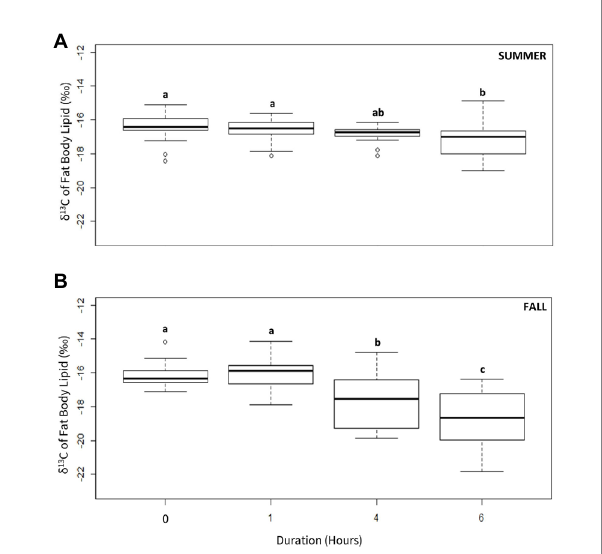
FIGURE 3 δ 13 C values of the fat body from 5-day old true armyworm moths after different periods of force flight when reared under (A) summer or (B) fall conditions. Letters indicate statistically significant differences in isotopic values as a function of flight time (Tukey’s HSD, p < 0.05). N = 10 per sample group ( N = 20 in Day 5 no